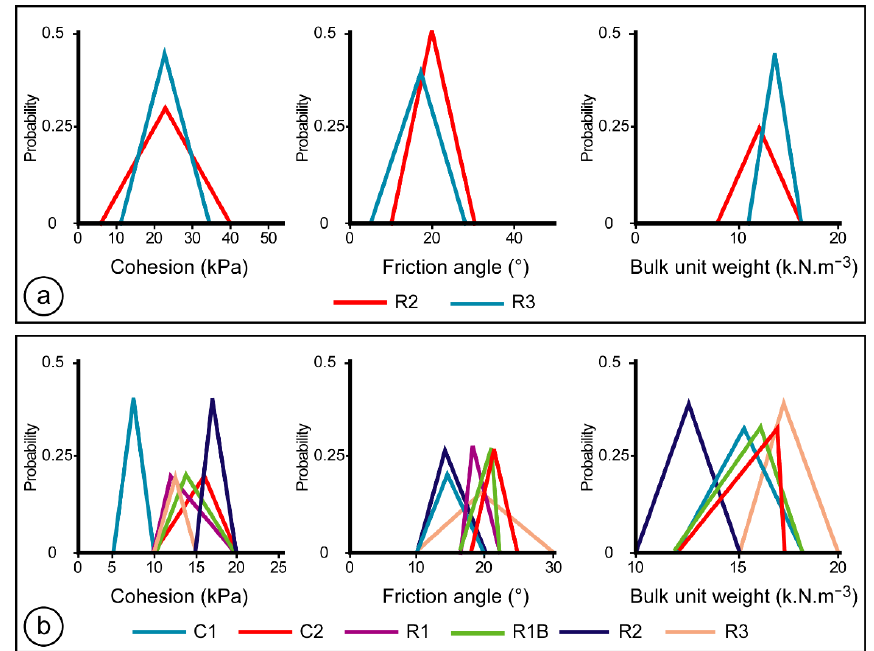
Figure 10. Representation of probability distributions of different materials. ( a ) La Médaille landslide; ( b ) Morne-Figue area.